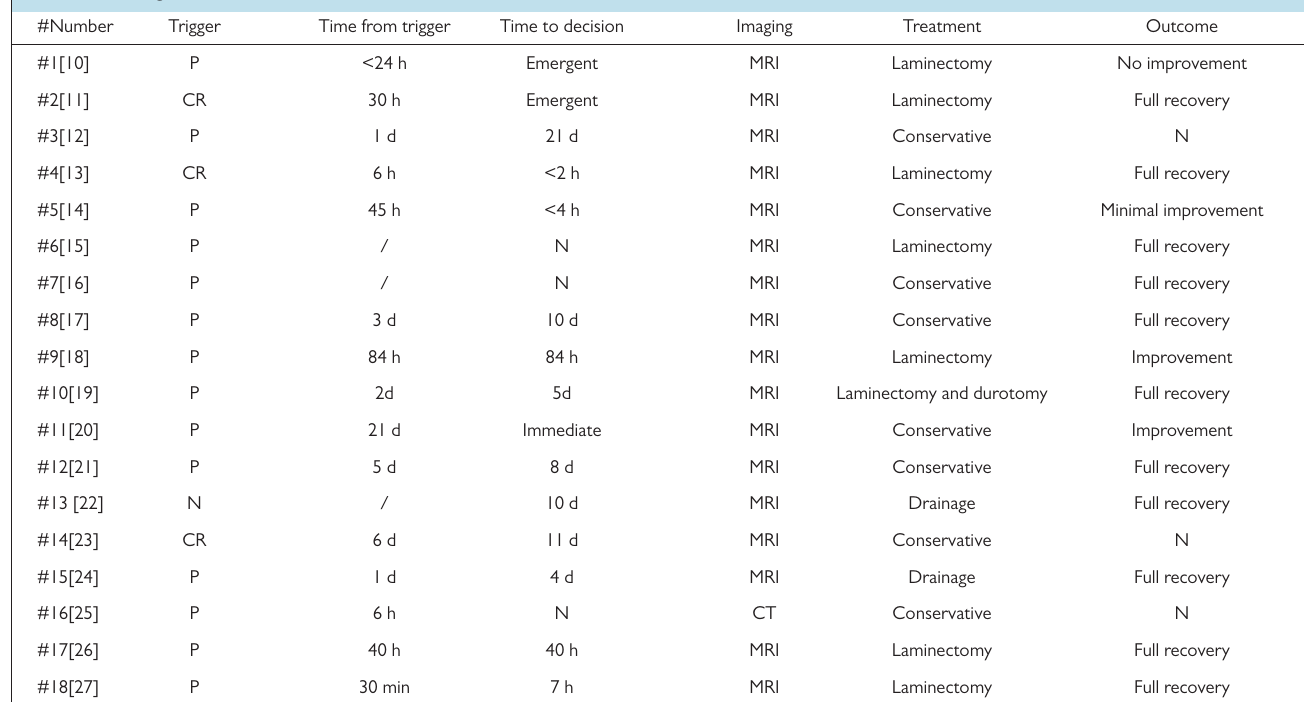
Table 4. Timing to treatments and